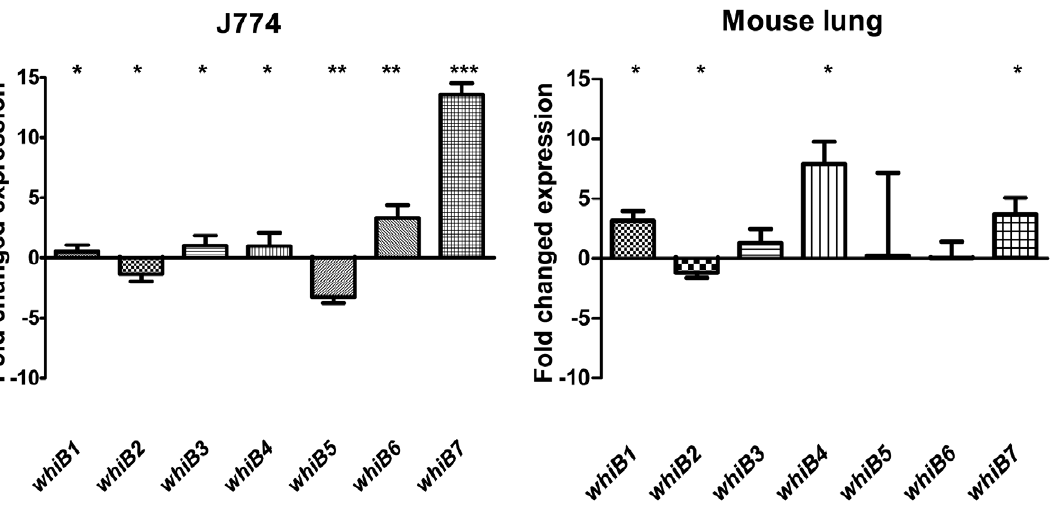
Figure 5. whiB1-7 expression in J774 macrophage-like cells and lungs of C3HeB/FeJ mice. Expression levels compared to aerobic in vitro 7H9 growth. Only whiB6 and whiB7 were upregulated during J774 cell infection whereas whiB1, 2 4 and 2 7 were upregulated in the lungs of C3HeB/ FeJ mice (5 weeks post-infection).